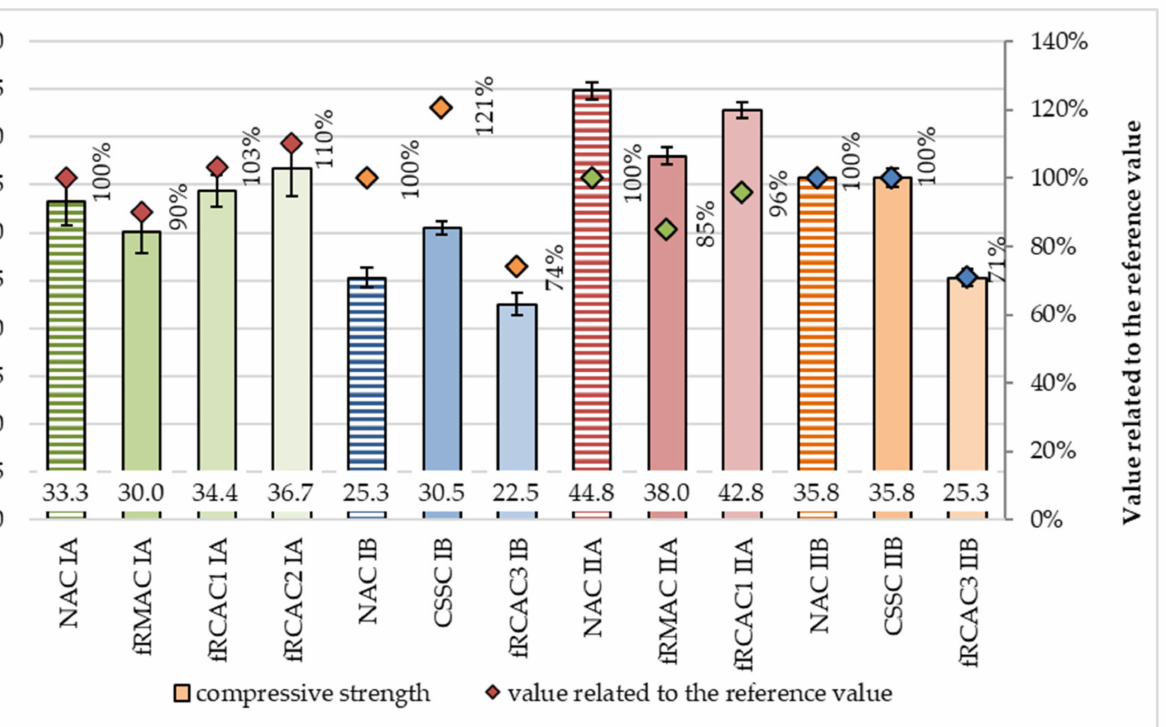
Figure 5. Comparison of compressive strength at 28 days of concrete containing fNA, fRCA, and fRMA with respect to control